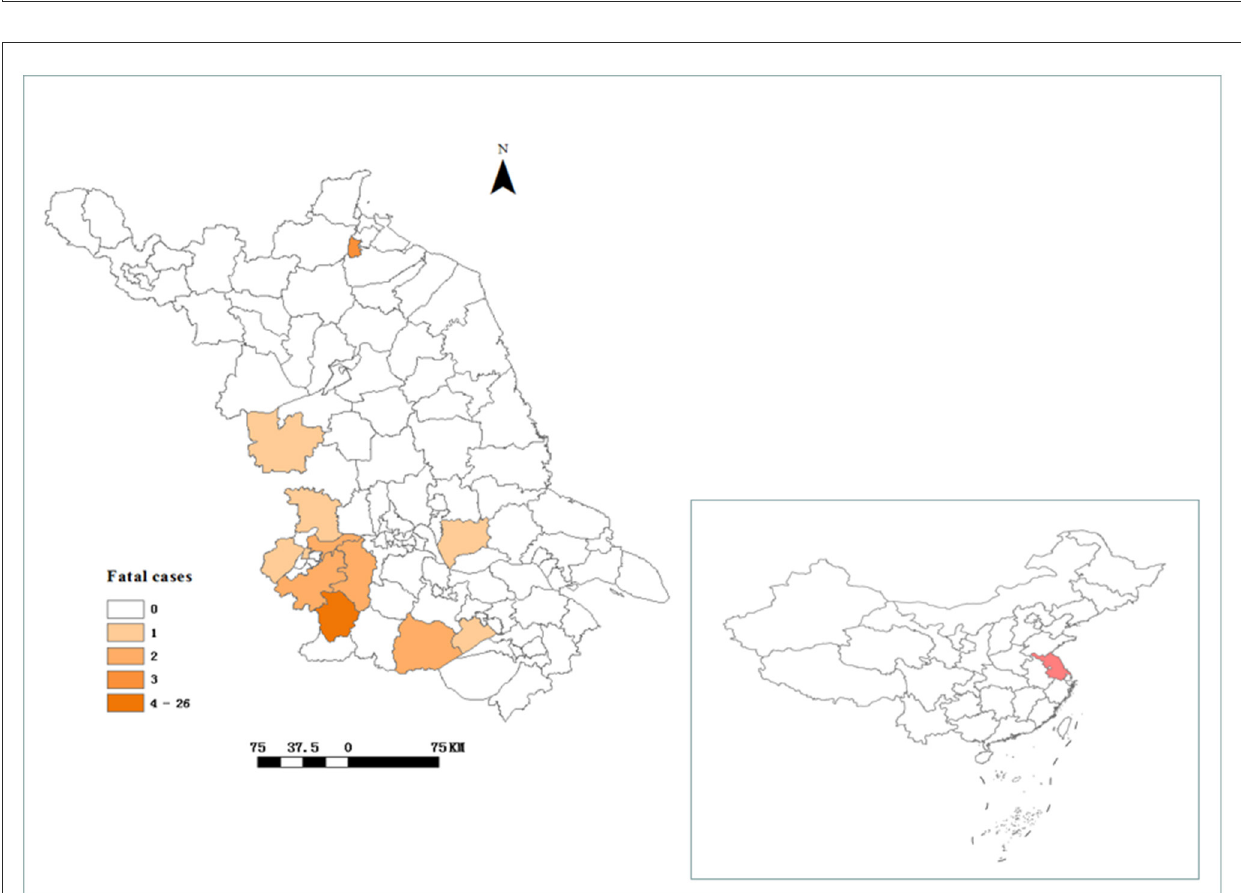
FIGURE2 The location of Jiangsu province and the geographical distribution of fatal cases of SFTS in Jiangsu province from 2011 to 2022.